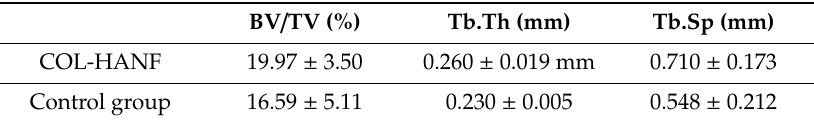
Figure 12. Micro-CT sections of the unimplanted group ( a~ c) and COL-HANF group ( d~f ). ( a )&( d ) Horizontal plane. ( b )&( e ) Sagittal plane. ( c )&( f ) Coronal plane. Horizontal plane. ( b , e ) Sagittal plane. ( c , f ) Coronal plane. Table 1. Bone volume / total volume (BV / TV), trabecular thickness (Tb.Th) and trabecular separation Table 1. Bone volume/total volume (BV/TV), trabecular thickness (Tb.Th) and trabecular separation (Tb.Sp) for defects implanted with the COL-HANF sca ff old and for unfilled defects (control group). (Tb.Sp) for defects implanted with the COL-HANF scaffold and for unfilled defects (control group). Mean ± SD; n = Mean ± SD; n = 3.